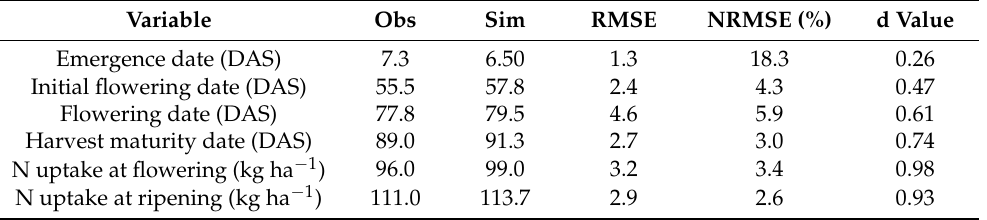
Figure 6. Comparison of observed (solid lines) and simulated (dotted lines) soil water storage in the 0–100 cm layer in model validation. Experimental data under high nitrogen in 2018 were used. NI —no irrigation; I1 —irrigation only at flowering; I2 —irrigation at tillering and jointing; I3 —irrigation at tillering, jointing, and flowering. Error bars indicate one standard deviation from the mean observed. Table 4. Descriptive statistics of the performance of APSIM-oat in modeling phenology and N uptake of oat in model